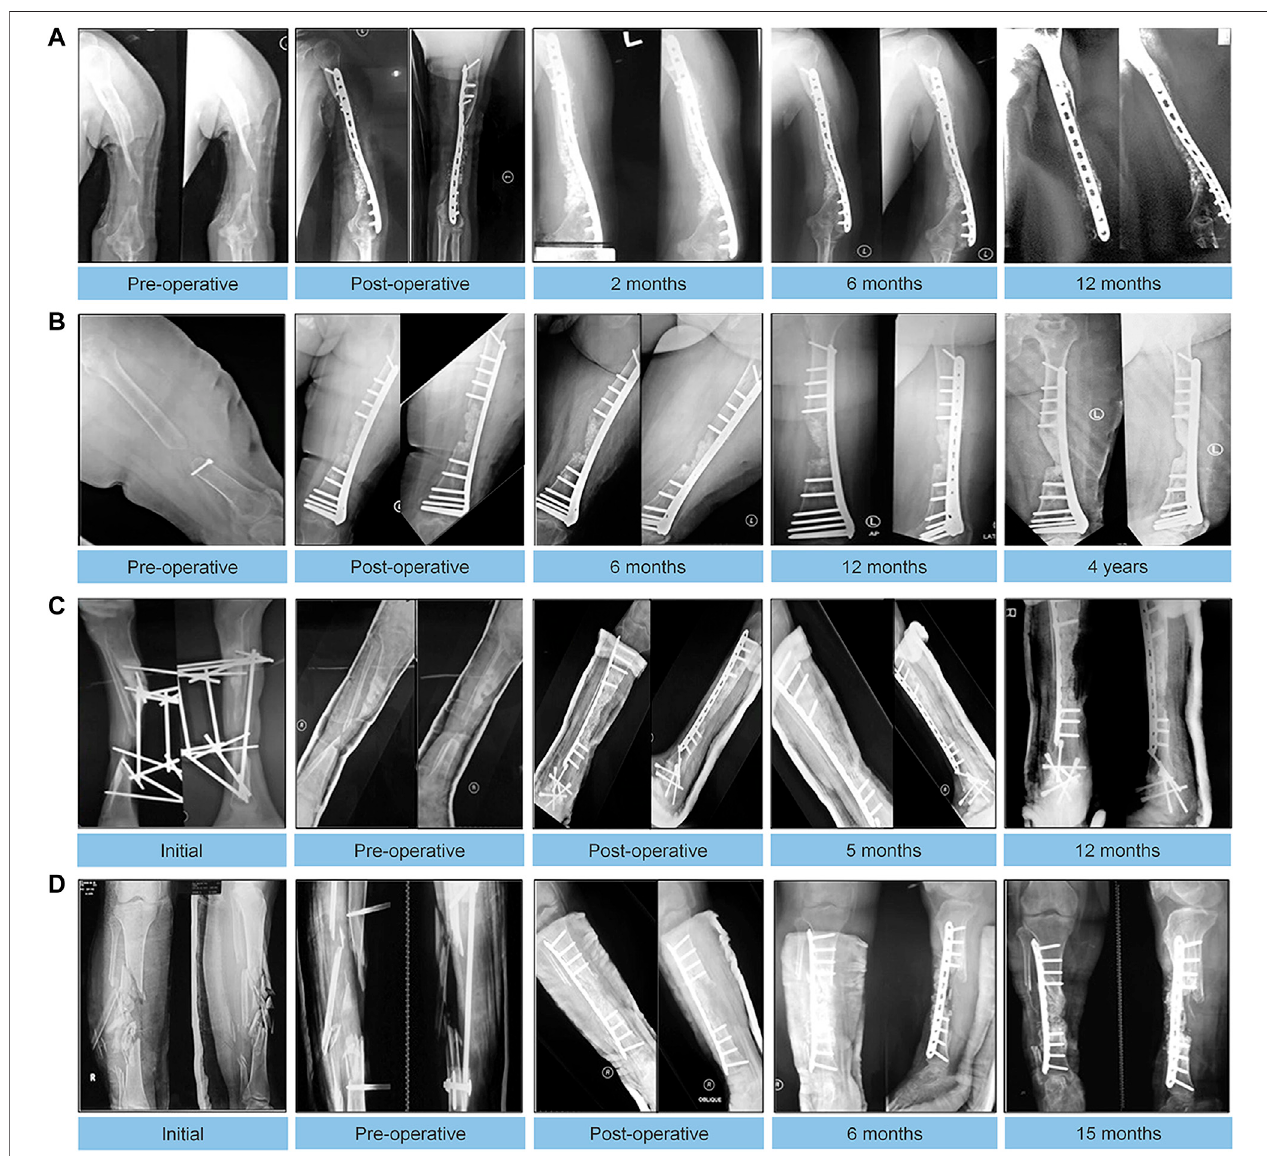
FIGURE8| AutologousMSCimplantation,hydroxyapatite, BMP-2,andinternal fi xation fortreatingcritical-sizeddefects. Radiographicresultsoffollow-up visitsof 4cases. (A) :An18-year-oldmalewith5-cmbonedefectofthehumerus. (B) :An18-year-oldmalewith5-cmbonedefectofthehumerus. (C) :A28-year-oldmalewith7- year history of 8-cm bone defect of the right tibia. (D) : A 24-year-old female with 12 cm bone defect of the tibia. Reprinted with permission from (Dilogo et al., 2019).